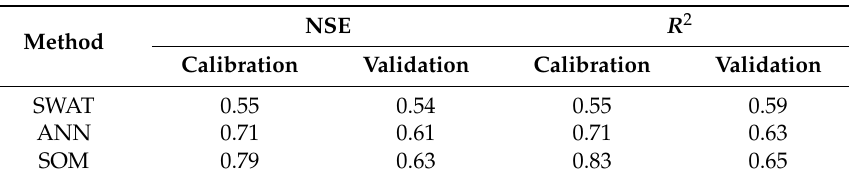
Table 3. Calibration (training) and validation statistics for daily streamflow. NSE: Nash–Sutcliffe efficiency; R 2 : regression coefficient.